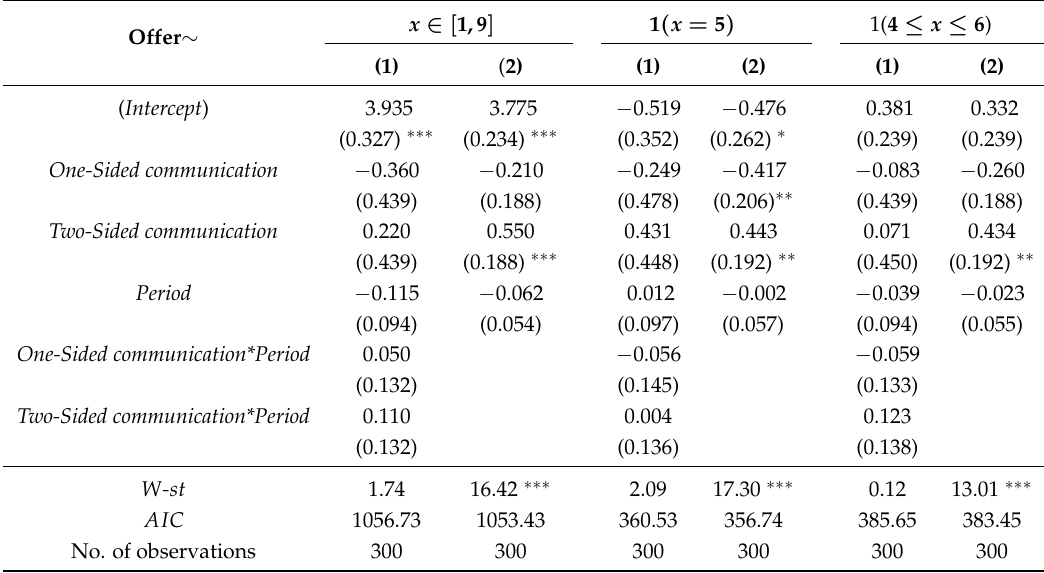
Table A3. Choices of X (Random Effects: linear and